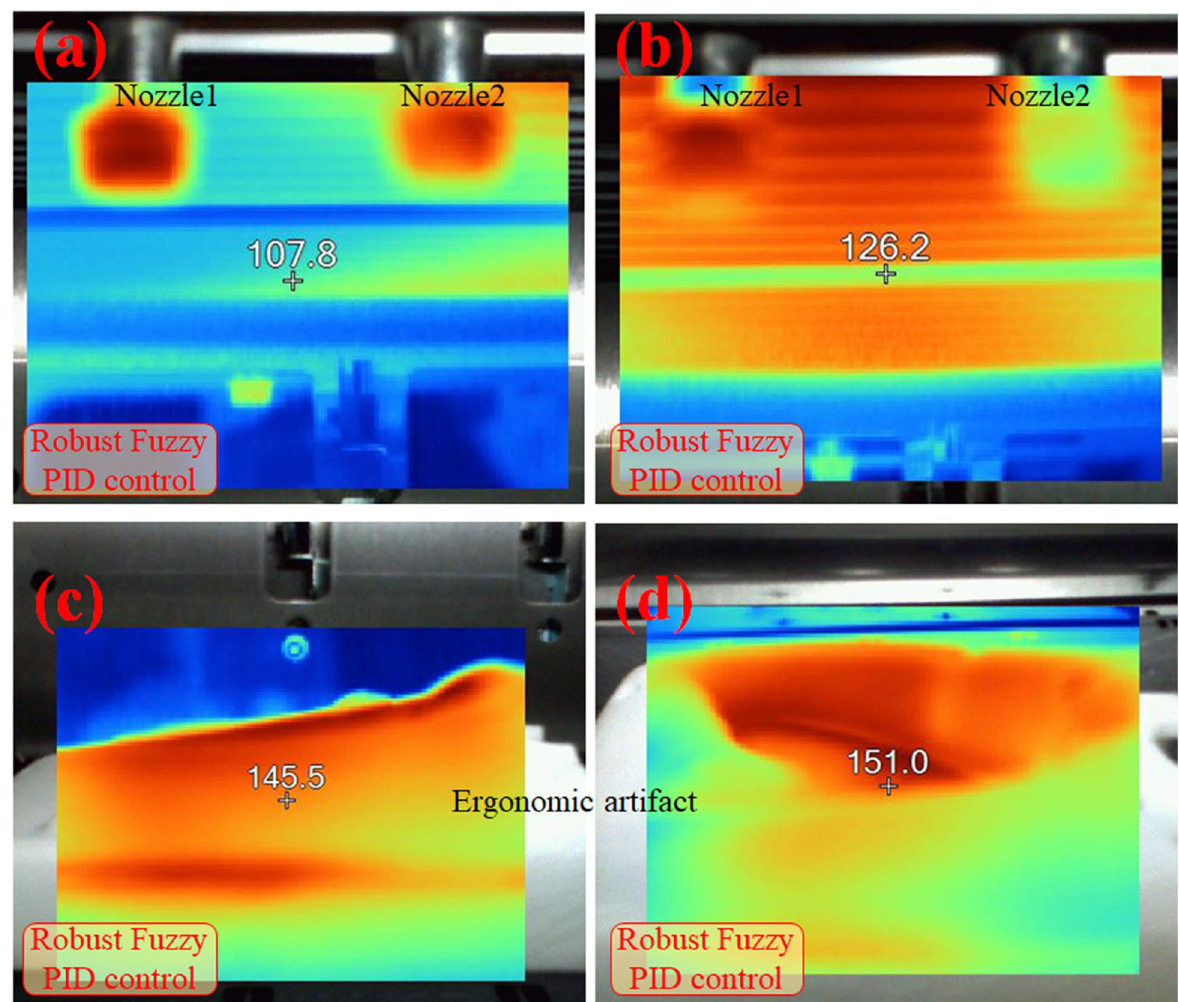
Fig. 6 Focused infrared thermographs during the thermoplastic process of a GF composite. The maximum temperatures are 107.8 ℃ , 126.2 ℃ , 145.5 ℃ , 151.0 ℃ , respectively, within almost sealed, high-temperature chamber, in ( a , b , c , d ) upon using fuzzy